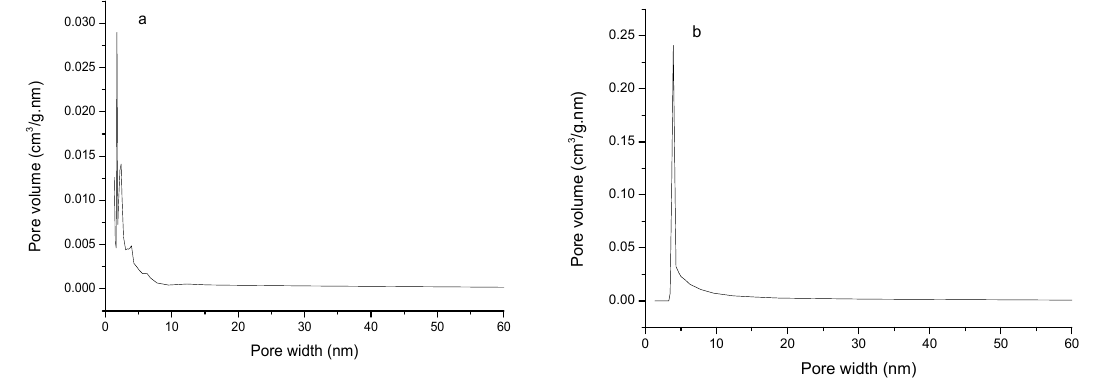
Figure 11. Pore size distribution of Fe / Mn ( a ) and Mn-doped Fe / rGO ( b ).